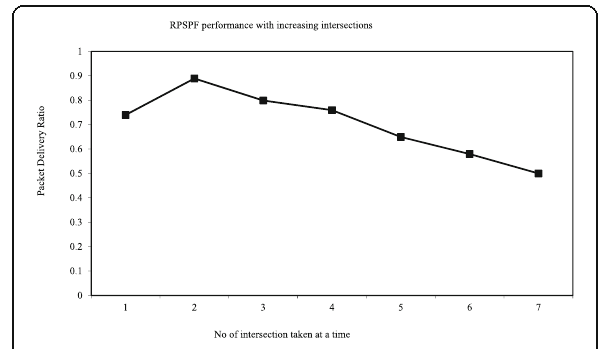
Fig. 12 Packet delivery ratio vs increasing number of intersections dynamically at a time in 400 nodes. RPSPF indicates Reliable Path Selection and Packet Forwarding Routing Protocol which is the proposed approach. It is presented in the figure with a solid line having a